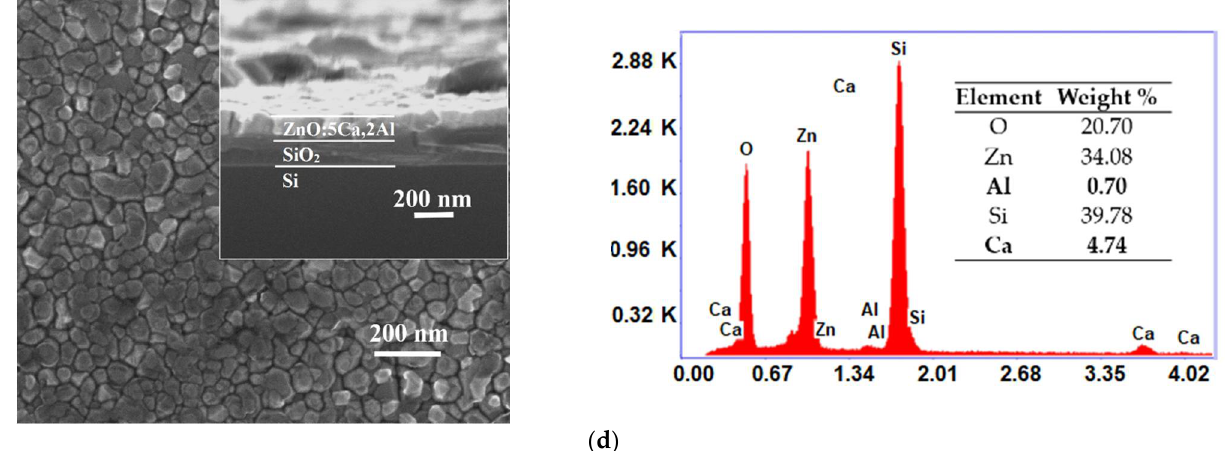
Figure 2. Surface morphology (inset: cross-sectional image) and EDX spectra of ZnO:Al 2% ( a ) and Ca-doped ZnO:Al 2% thin films with: 1, 3 and 5% Ca: ( b – d ).